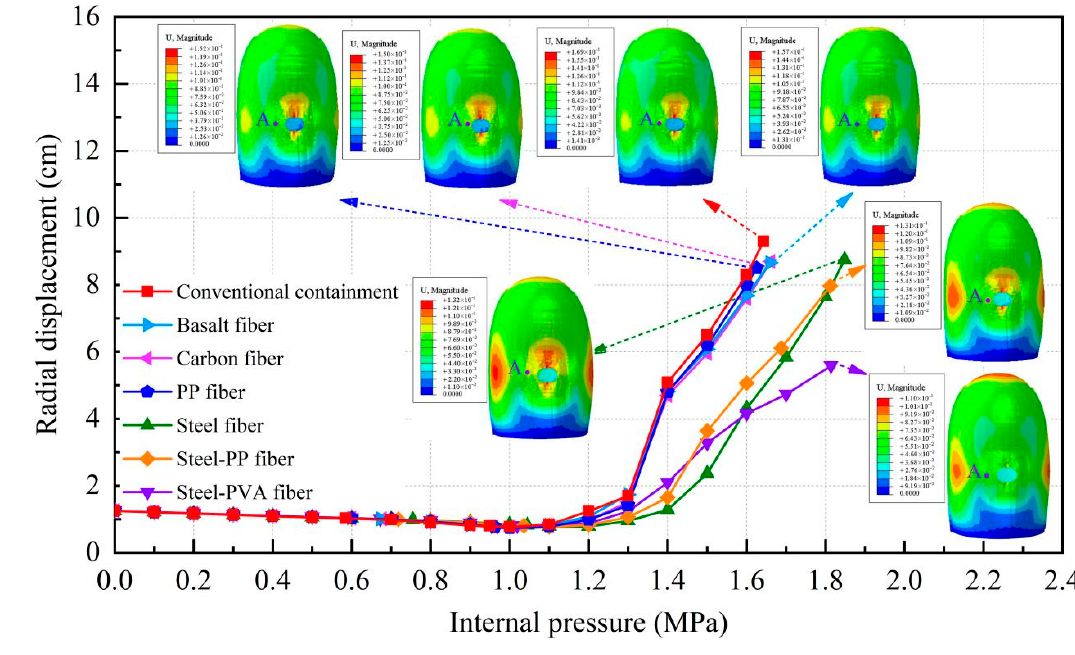
Figure 12. Radial displacement curve of point A.